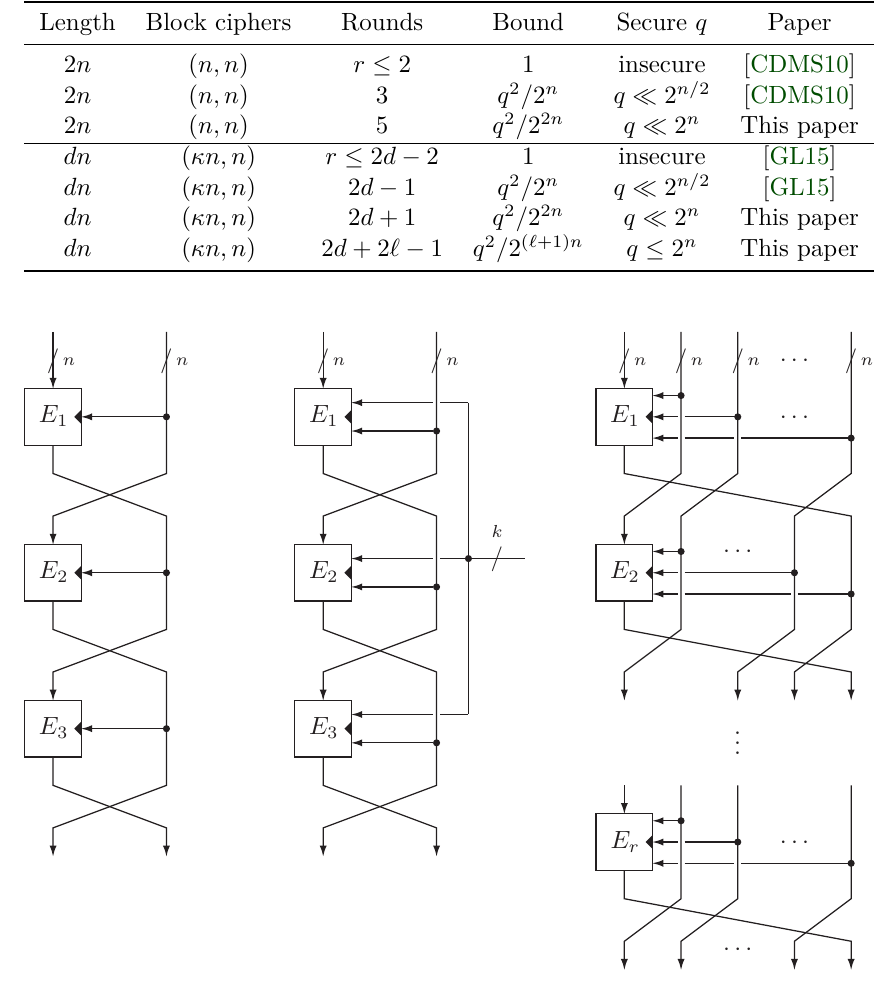
‘ d 1, and q = q c + q p . ( k, n ) in the ≤ ≤ −